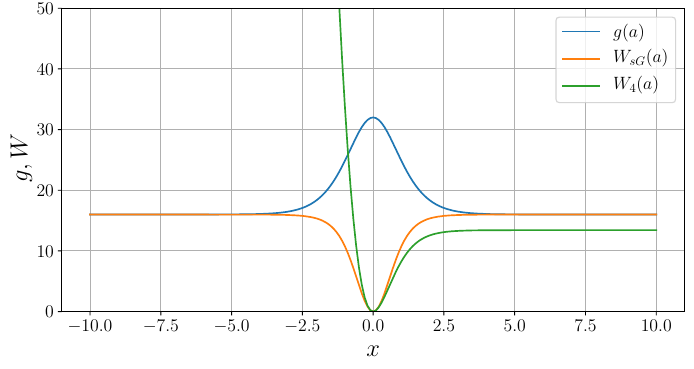
Figure 9 . Metric and effective potentials for small values of (cid:15)